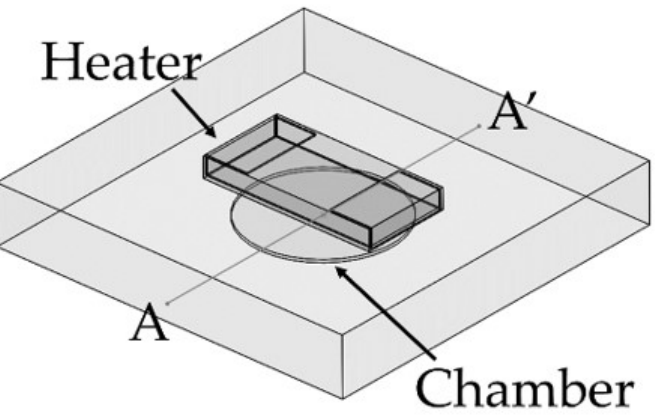
Figure 1. Illustration of the PCR microchip using a chip resistor as a heater. The chamber was located in a glass substrate (12.5 mm × 12.5 mm × 2 mm), and the diameter and the height of the PCR reaction chamber were 5 mm and 0.1 mm,